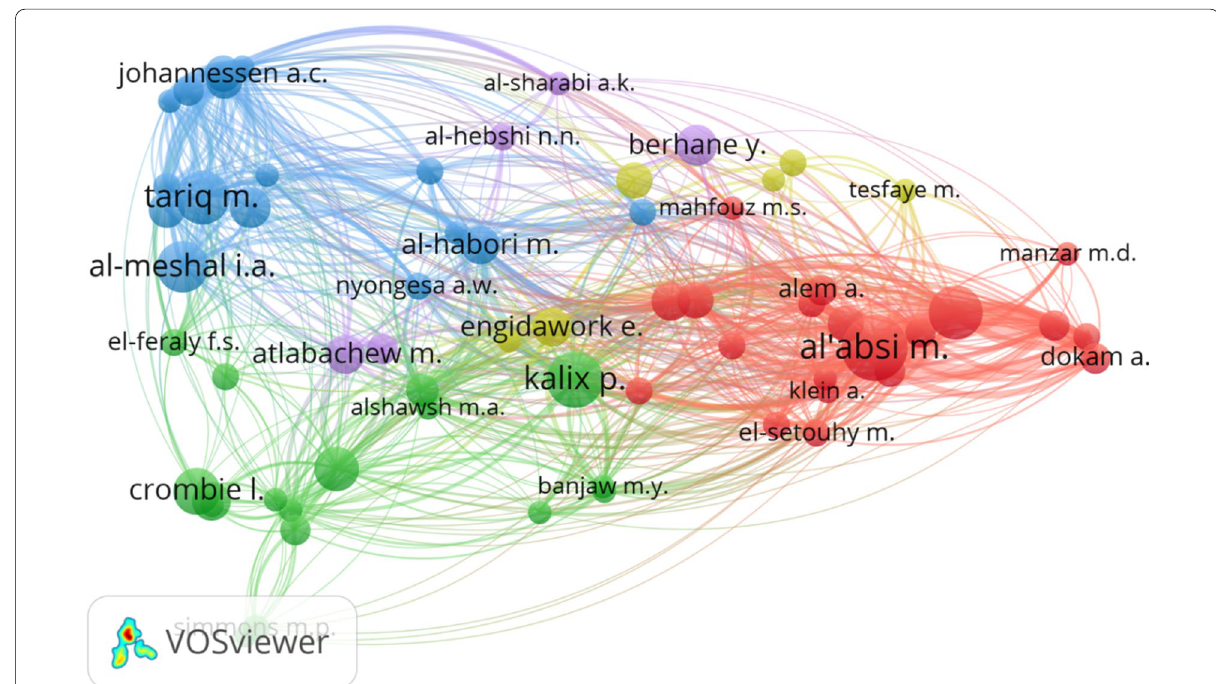
Fig. 7 Networks of cited authors having five or more citations. Only authors with five or more citations were mapped ( n citations is related to the thickness of the connecting line between the two authors